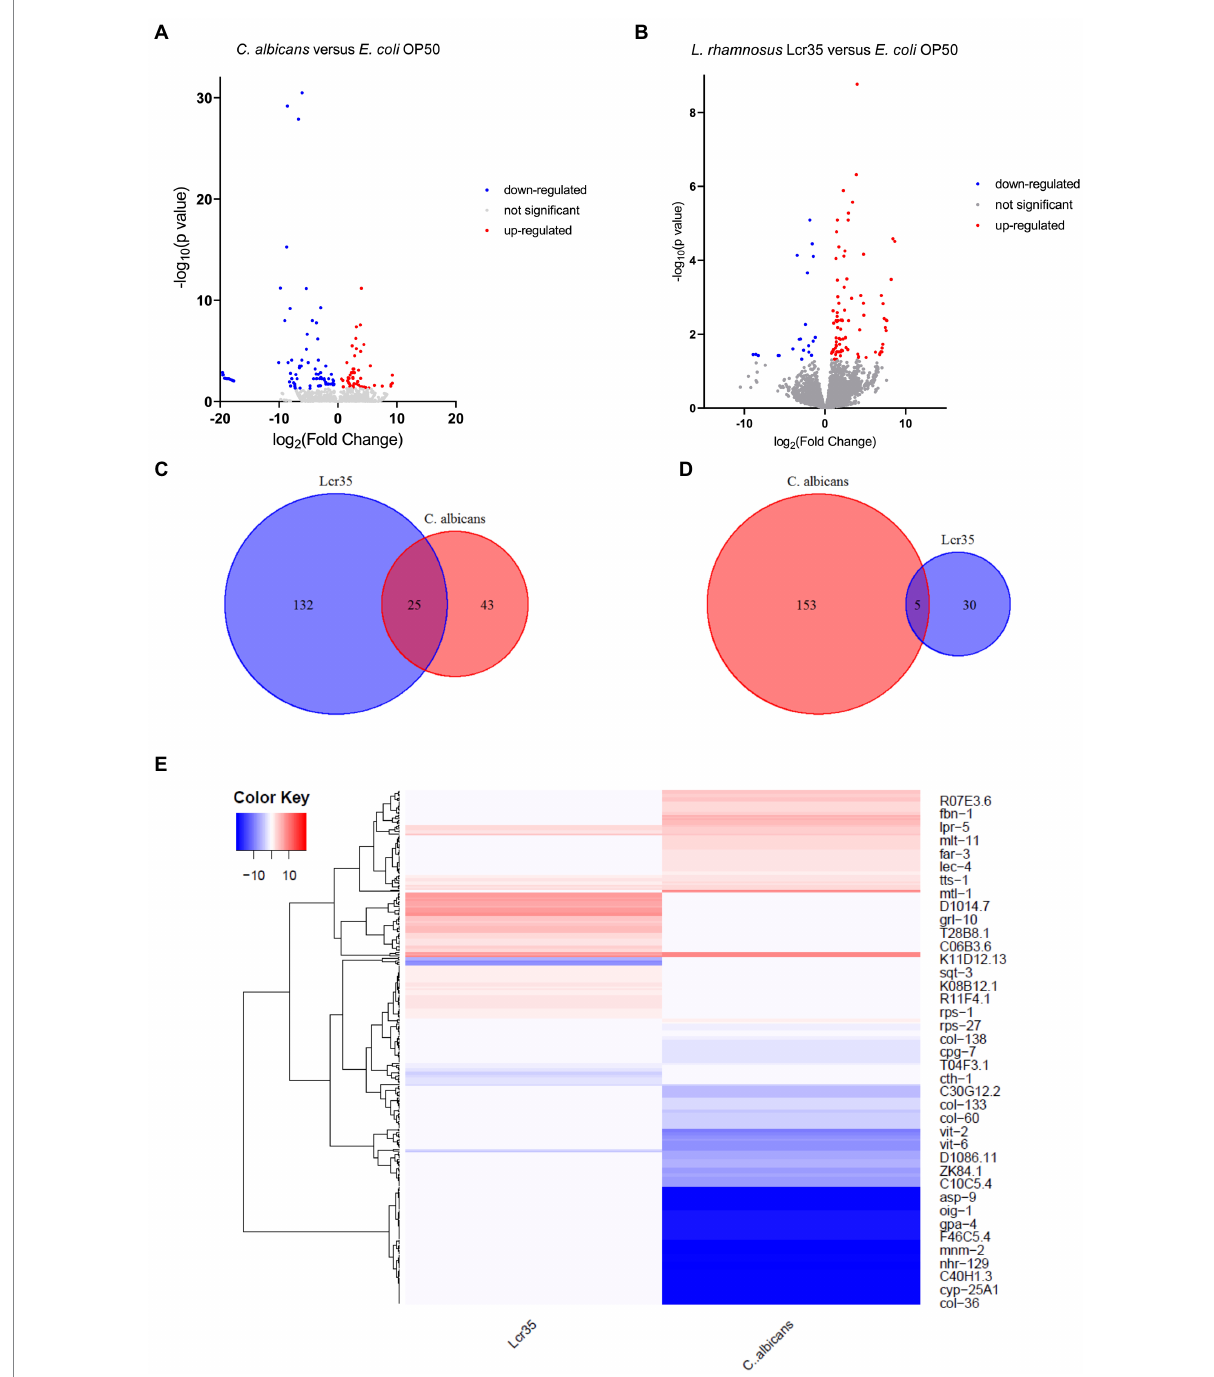
FIGURE 3 Transcriptomic analysis of C. elegans N2 fed with L. rhamnosus Lcr35 ® or C. albicans ATCC 10231. (A) Volcano plot displaying differentially expressed genes between C. albicans and E. coli OP50 conditions. (B) Volcano plot displaying differentially expressed genes between L. rhamnosus Lcr35 ® and E. coli OP50 conditions. The transcriptional responses to C. albicans and L. rhamnosus Lcr35 ® comprise specific and overlapping gene sets. Venn diagrams illustrate the overlap genes significantly upregulated (C) or downregulated (D) by C. albicans and L. rhamnosus Lcr35 ® . (E) Clustering heatmap of differentially expressed genes. Red color indicating significantly highly expressed genes and blue color indicating significantly down-regulated genes. Animals were exposed to the microbial strains for 4 h. The exhaustive list of genes is given in Supplementary Tables S1,